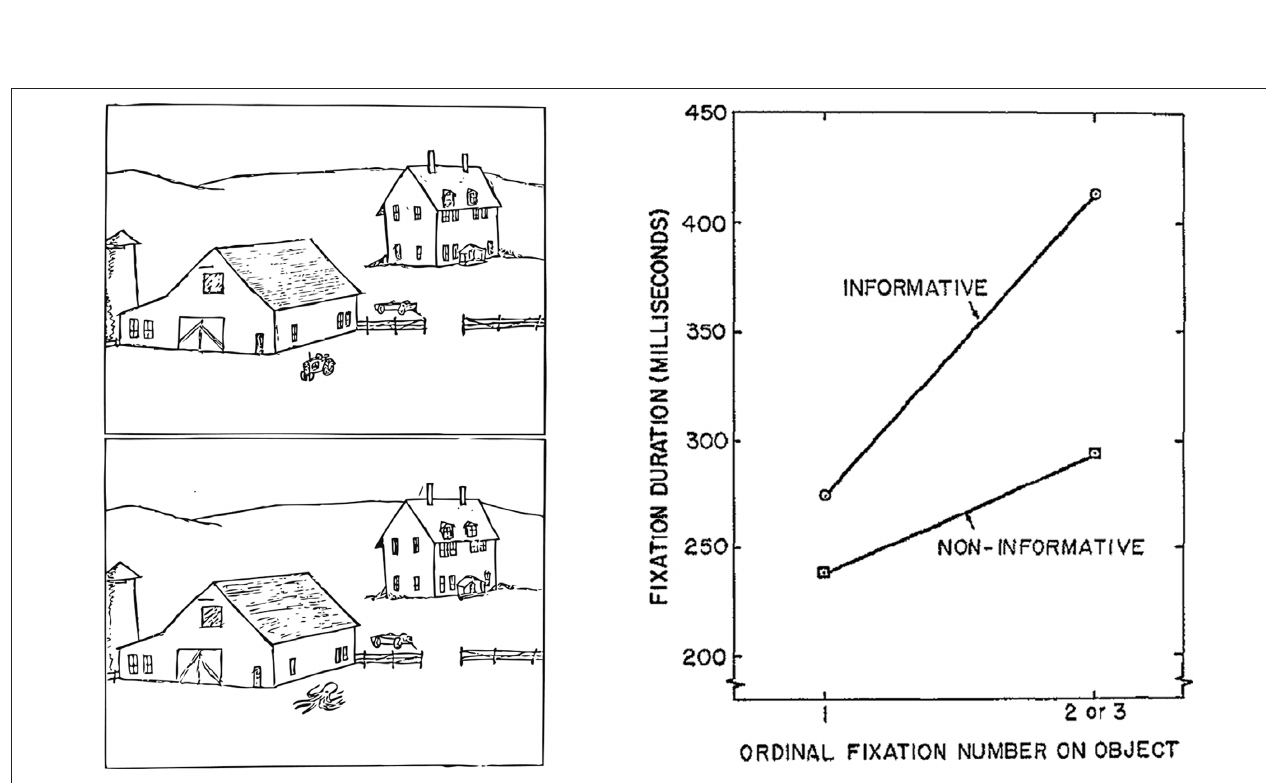
FIGuRE 1 | Illustration of the experimental methods and results from Loftus and Mackworth (1978). Participants viewed scenes in which an object was either consistent (i.e., a tractor; top), or inconsistent (i.e., octopus; bottom) with the semantic context of the scene (i.e., barnyard). Objects that